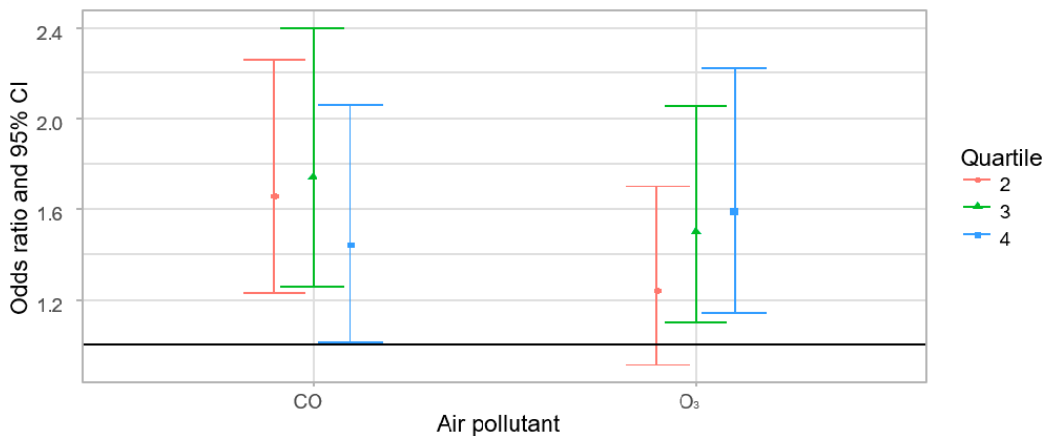
Figure 2. Conditional logistic regression results from the two-pollutant models for adjusted associations between one-year CO and O 3 concentrations and rheumatoid arthritis in adults abc . a Results adjusted for insurance type, body mass index (BMI), smoking status, alcohol consumption, and exercise status; b Results compared with the exposure in the lowest quartile (first quartile); c Two-pollutant model: O3 + CO.